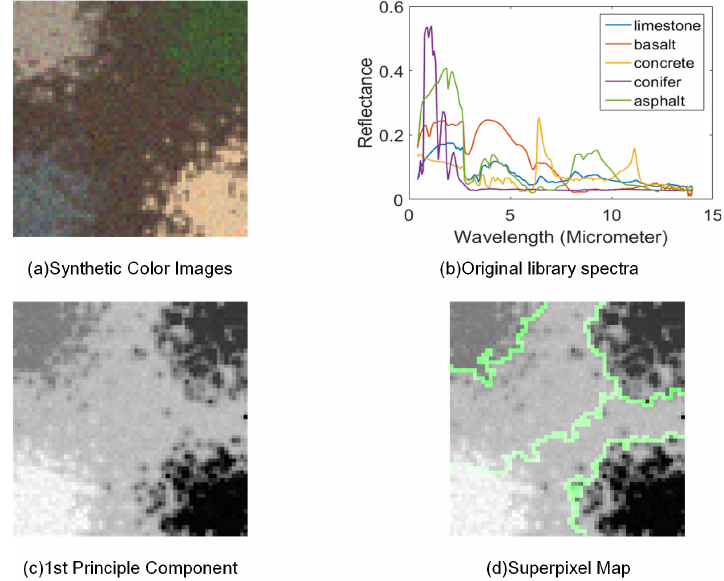
Figure 2. ( a ) The synthetic color images by extracting the bands corresponding to wavelengths 488 nm, 556 nm, and 693 nm; ( b ) the original spectra from the ASTER library; ( c ) the first principle component of the synthetic dataset; and ( d ) the superpixel map used for the synthetic